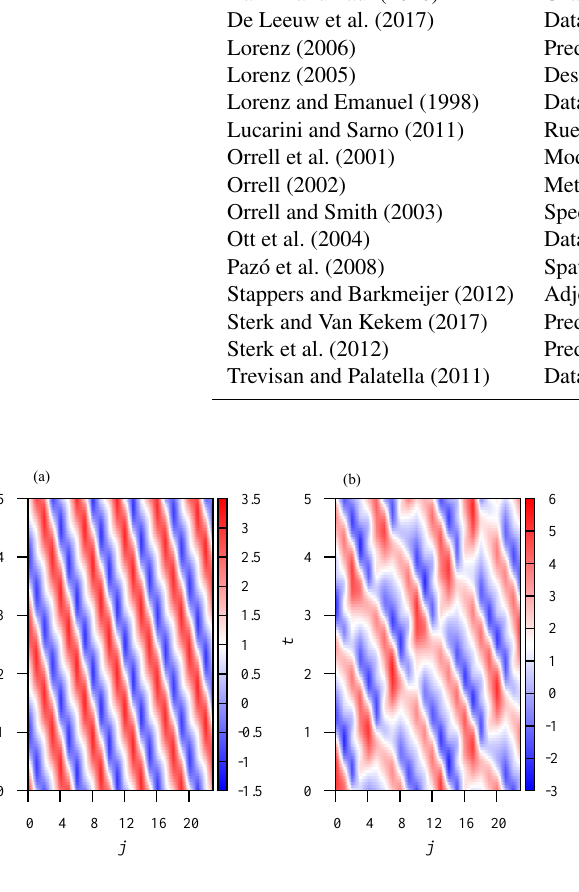
Figure 1. Hovmöller diagrams of a periodic attractor ( a , F = 2 . 75) and a chaotic attractor ( b , F = 3 . 85) in the Lorenz-96 model for n = 24. The value of x j (t) is plotted as a function of t and j . For visualization purposes linear interpolation between x j and x j + 1 has been applied in order to make the diagram continuous in the variable j